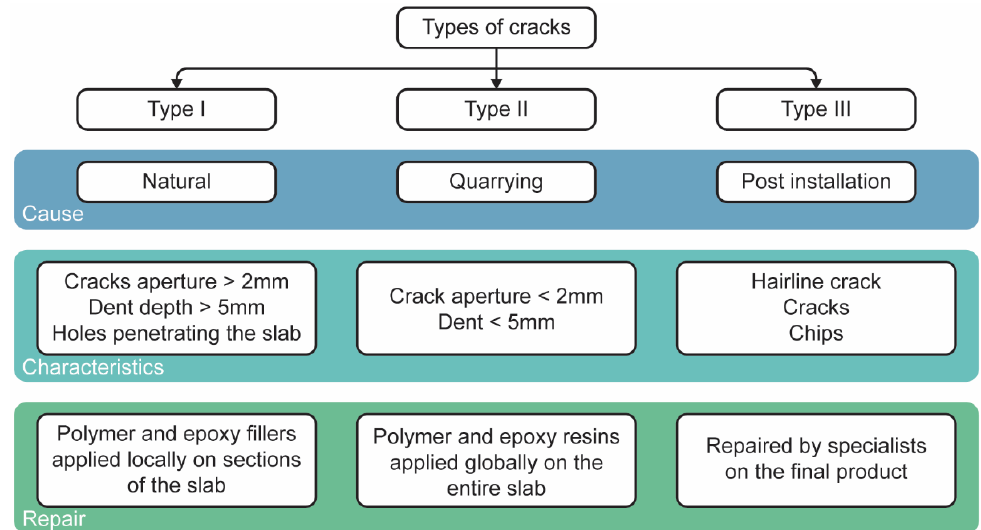
Figure 3. Types of cracks, cause, characteristics and their